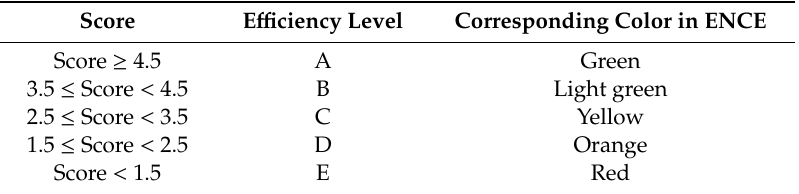
Table 3. E ffi ciency level classification by score